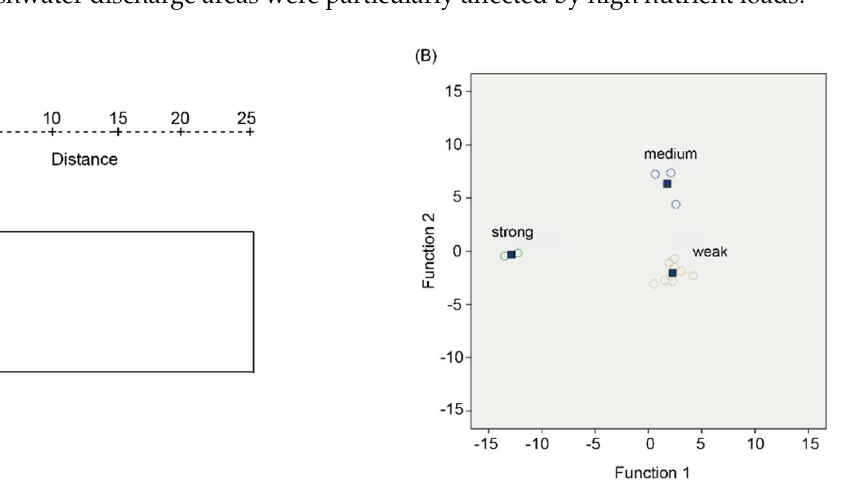
Figure 3. Hierarchical clustering and canonical correlation analysis of seawater quality data across sites. In the cluster tree ( A ), relative distances are shown, and in the CCA biplot ( B ), the mean (centroid) for each group is indicated by a square.